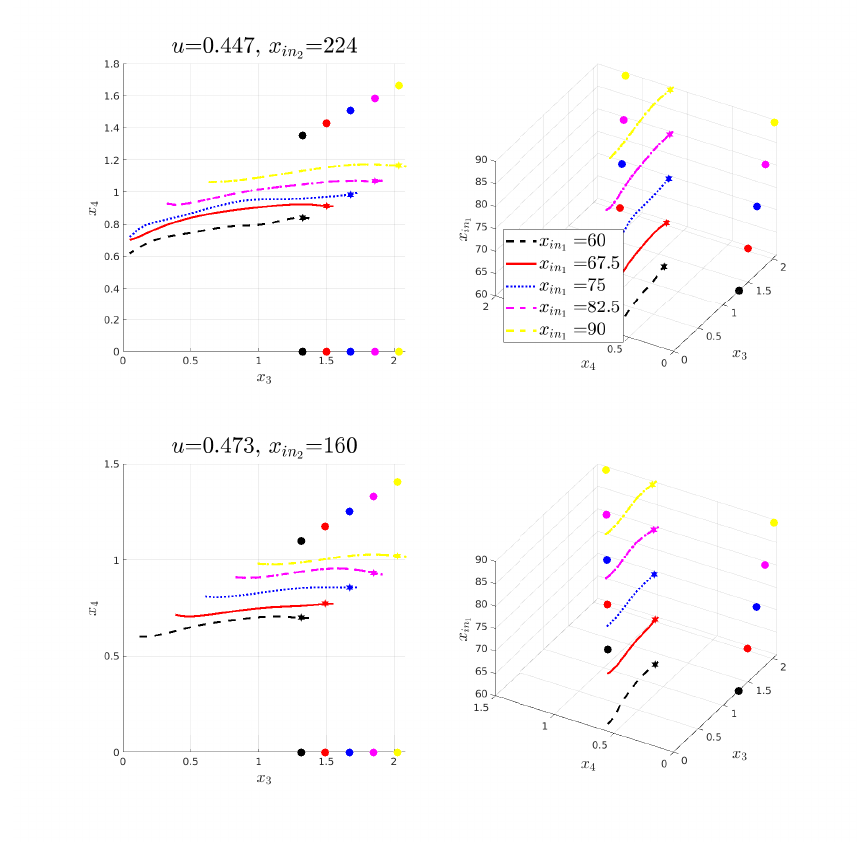
Figure 11: Intersection of the stable manifold, different realizations with different u , and constant concentrations at the input.